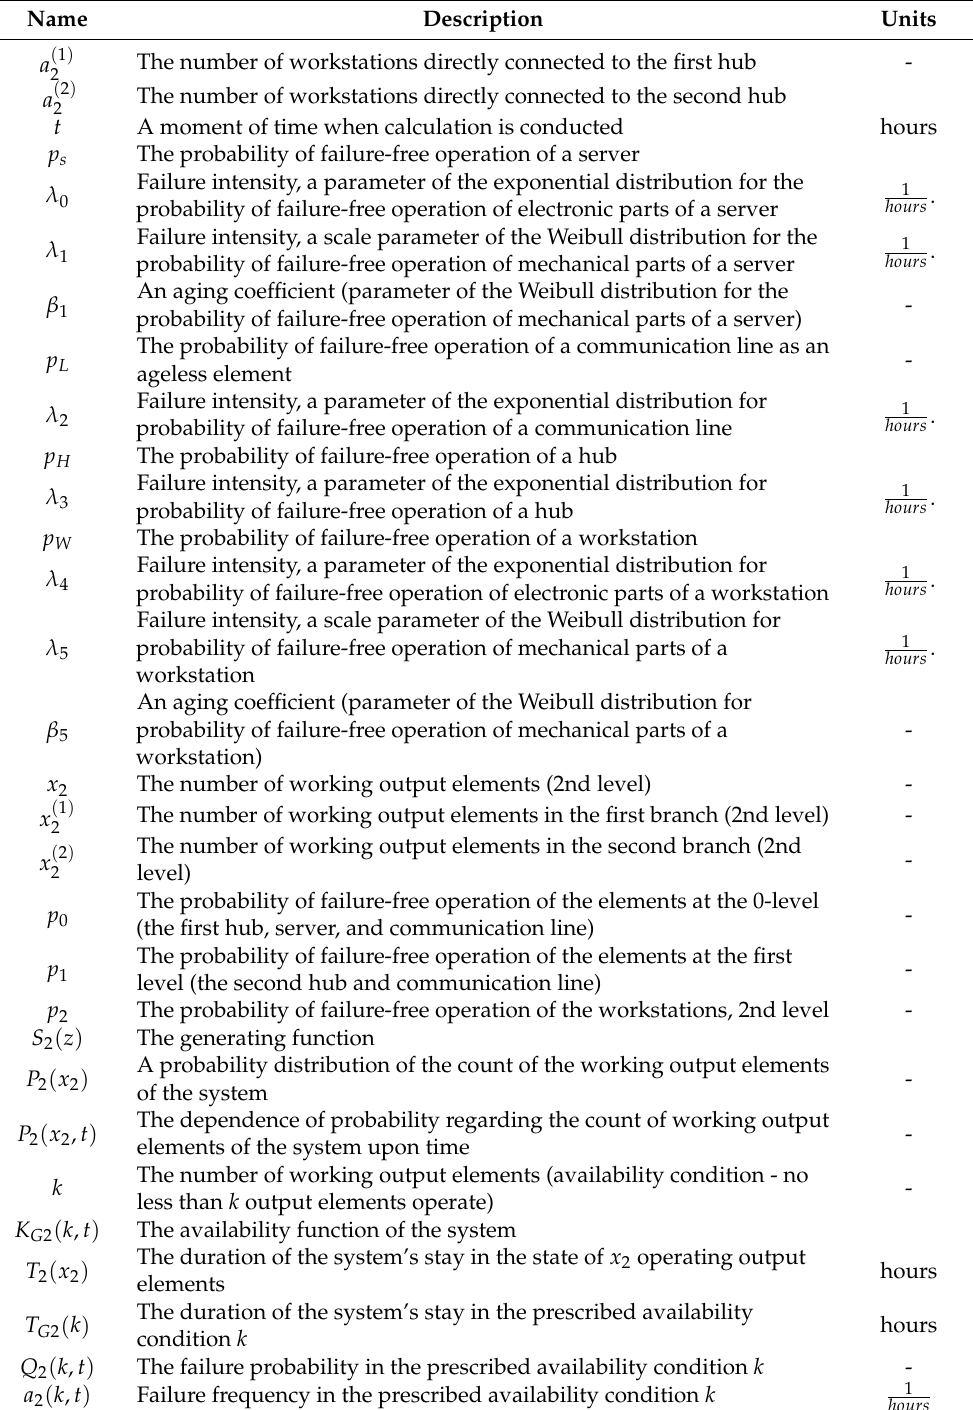
Table 1. Nomenclature of the variables and parameters used in the